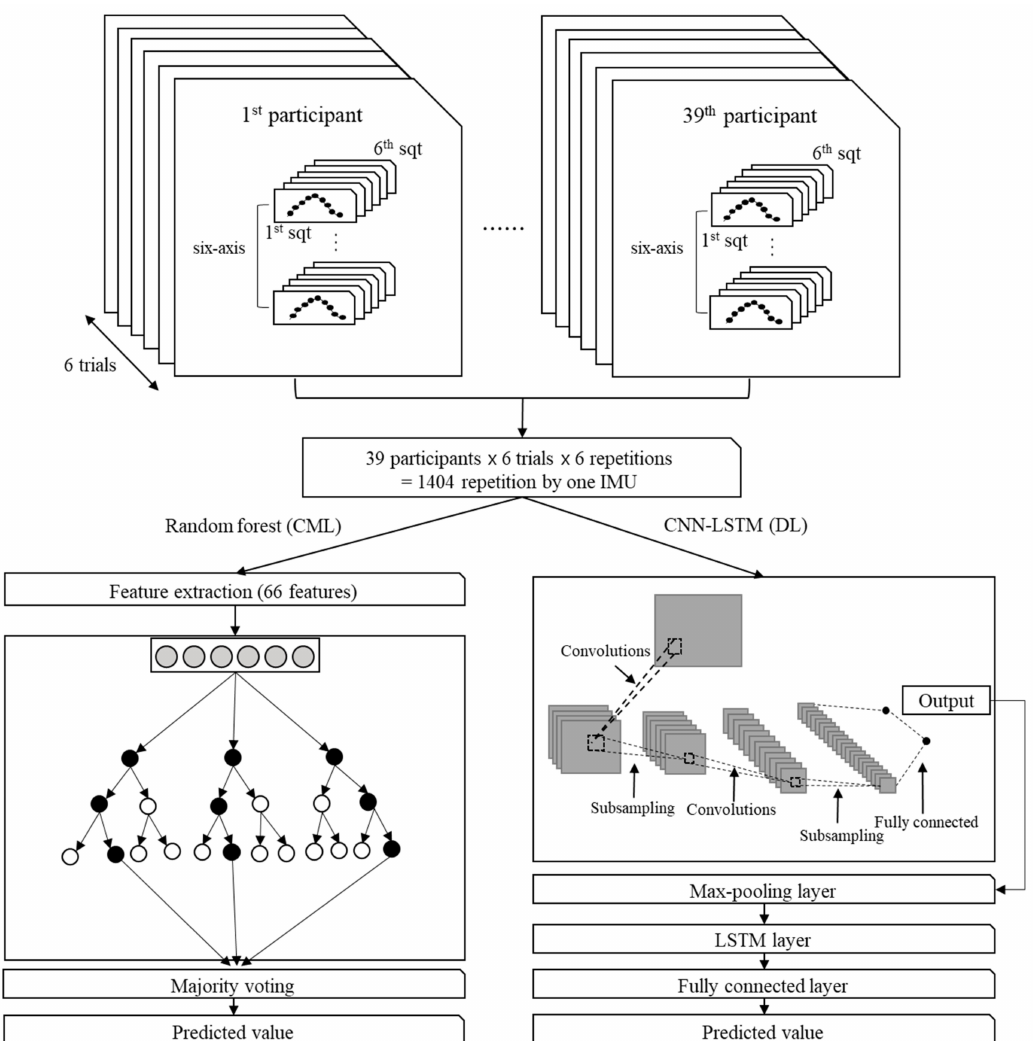
Figure 3. Processes used to train classification models (random forest and convolutional neural network–long short-term memory (CNN–LSTM)) via segmented repetitions of